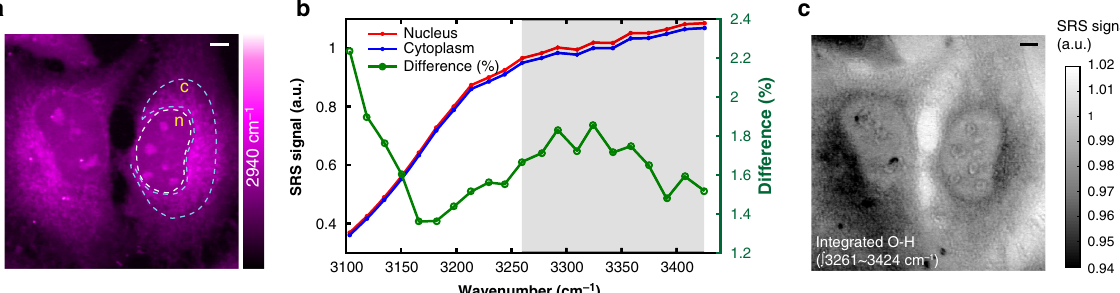
Fig. 4 Water density inside live HeLa cells measured by SRS microscopy. a SRS image at frequency of 2940 cm − 1 (CH 3 stretching attributed mainly to protein) of live HeLa cells. b Spectral mapping of O – H stretching band at the nucleus and cytoplasm regions marked in ( a ) (n stands for nucleus and c stands for cytoplasm). The difference curve (shown on the right in percentage) is calculated as (nucleus − cytoplasm)/nucleus. c SRS image on integrated O – H stretching band over 3261 – 3424 cm − 1 (the gray area in ( b ), which is the spectral region that differs the most). Scale bar: 5 μ m. The color scales display relative SRS signal distribution of (cid:1) ν we observed between nucleus and cytoplasm C (cid:4) N in vivo is from the water effect rather than the pure electrostatic effect.